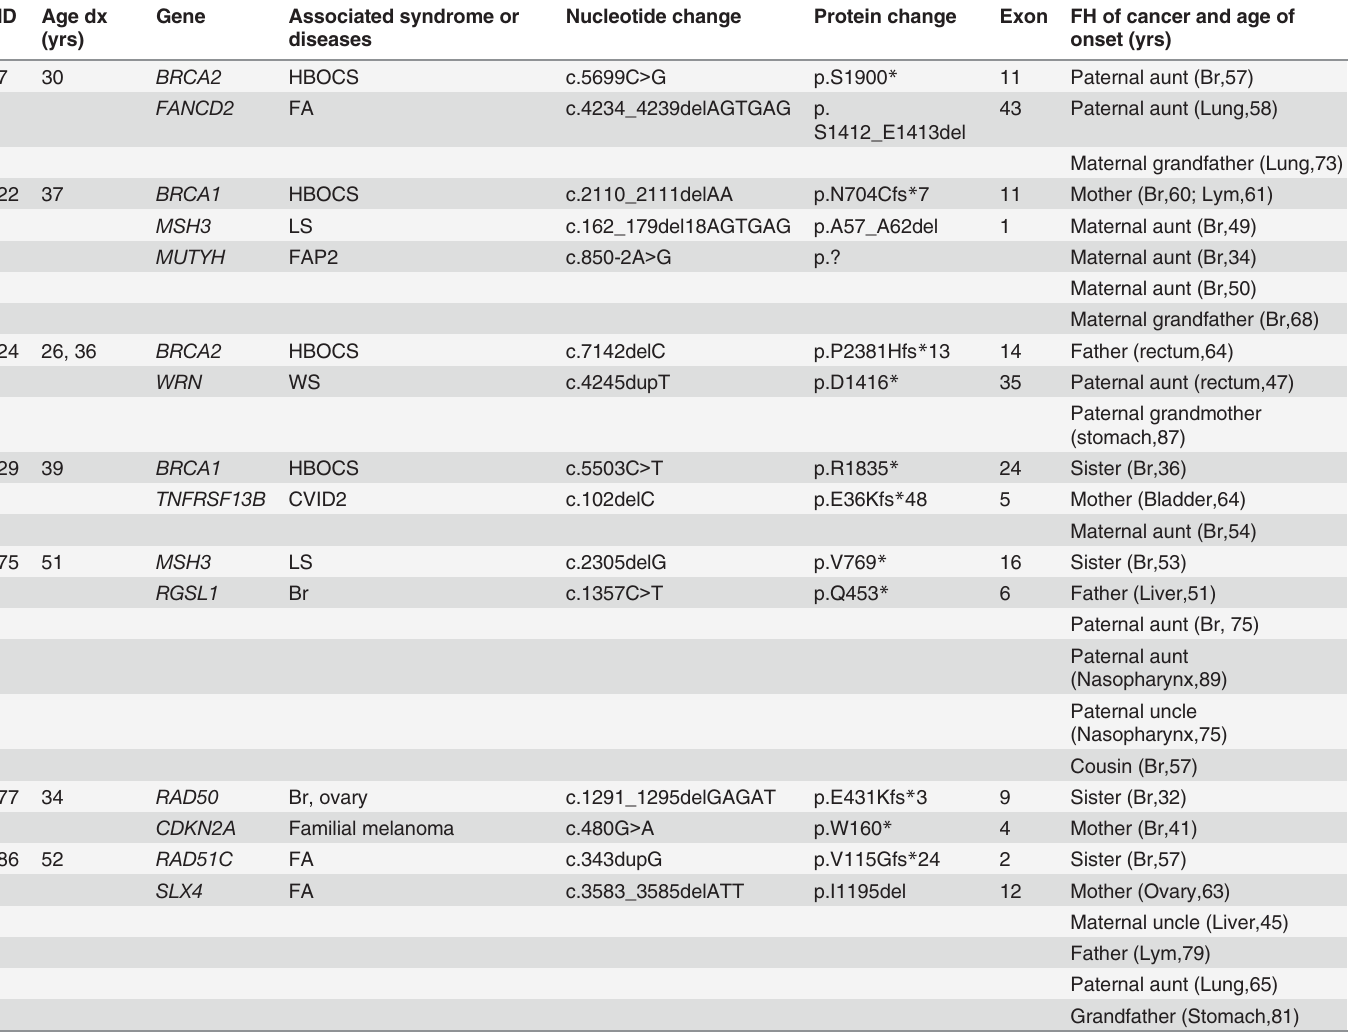
Table 3. Details of patients carrying mutations in two or more